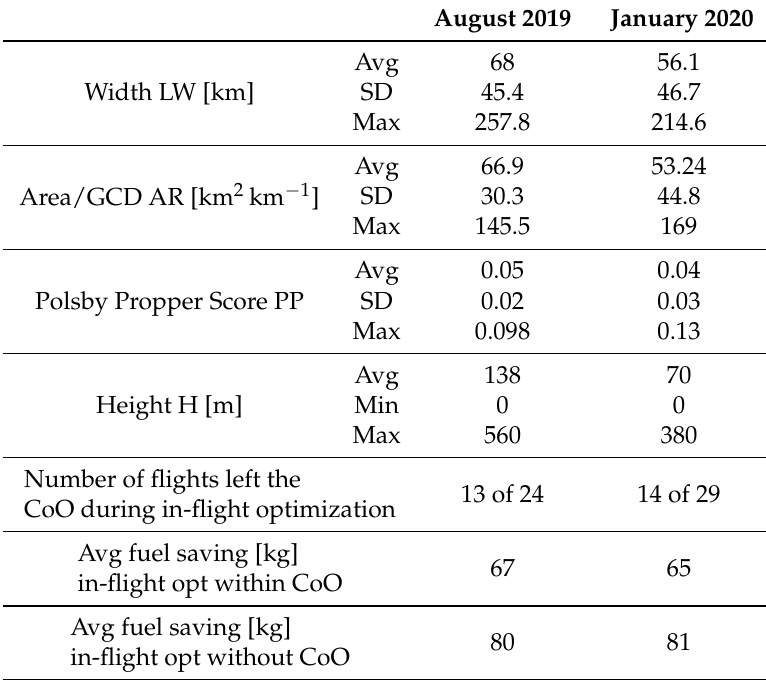
Table 3. CoO characteristics for August 2019 and January